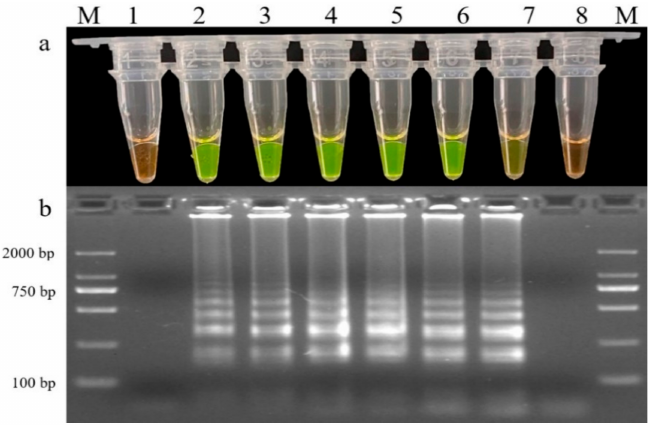
Figure 2. Profiles of LAMP reactions for P. graminea with serial concentrations of MgSO 4 solution. Assessments of LAMP products based on SYBR Green I visualization of color change ( a ) or agarose gel electrophoresis ( b ). Lane M, DNA ladder; tubes and lanes 1 to 7, LAMP reaction with MgSO 4 solution concentrations of 2.0, 4.0, 6.0, 8.0, 10.0, 12.0, and 14.0 mM, respectively; tube and lane 8, negative control with ddH 2